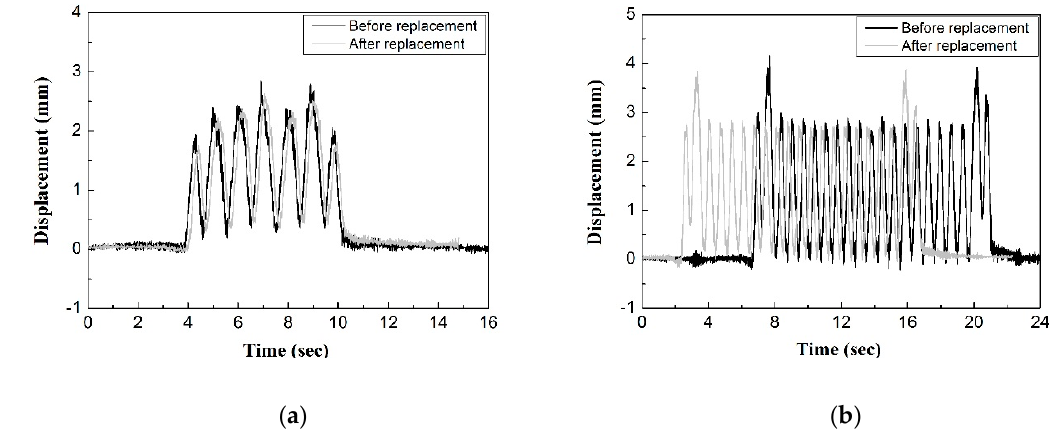
Figure 7. Examples of measured vertical displacements of the track girder before and after rail pad replacement. ( a ) AREX and ( b ) KTX.